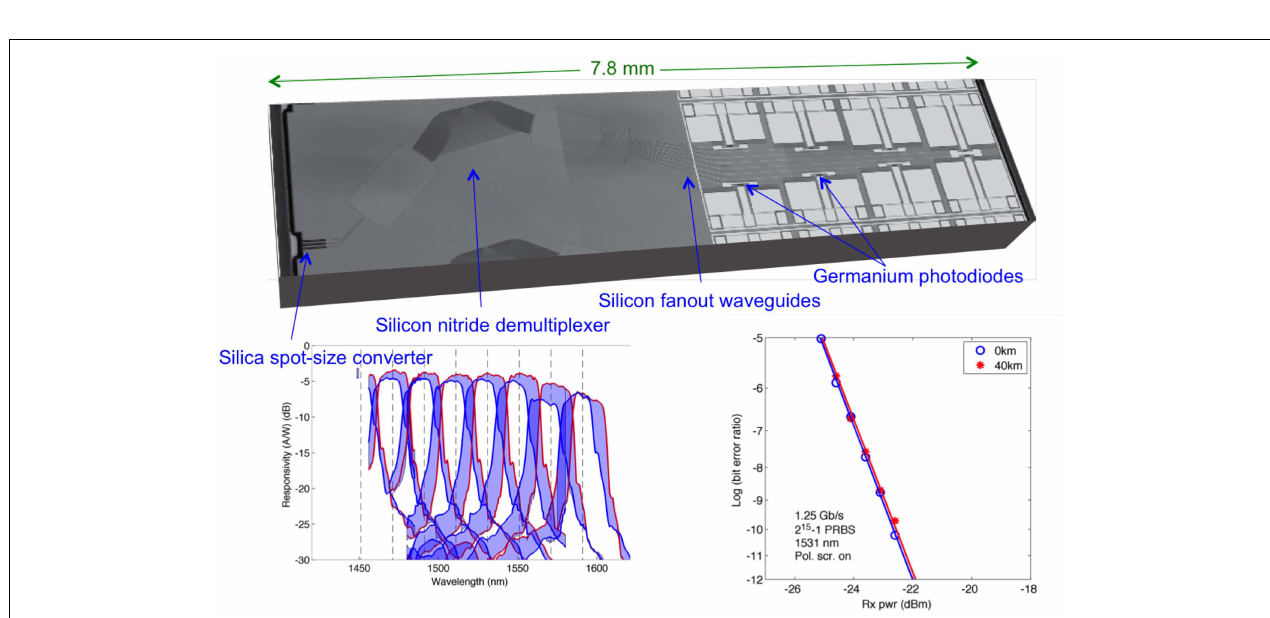
FIGURE 15 | Silicon photonics 8-WDM receiver. The upper figure shows a photograph of the chip, the lower left figure shows the measured responsivities to the 8 detectors vs. wavelength, and the lower right figure shows the measured bit-error rate at 1.25 Gb/s for one of the channels using a polarization scrambler.